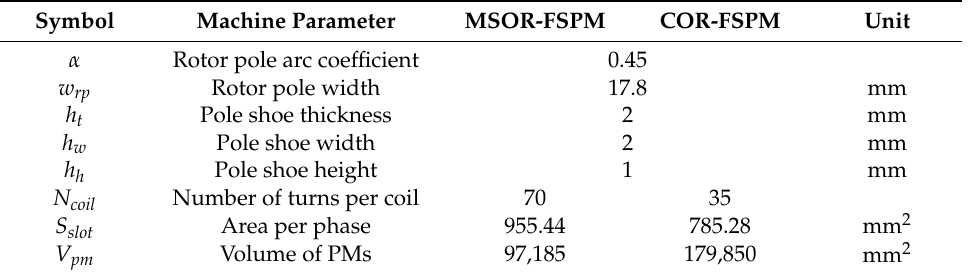
Table 4. Partial parameters of MSOR-FSPM motor and COR-FSPM